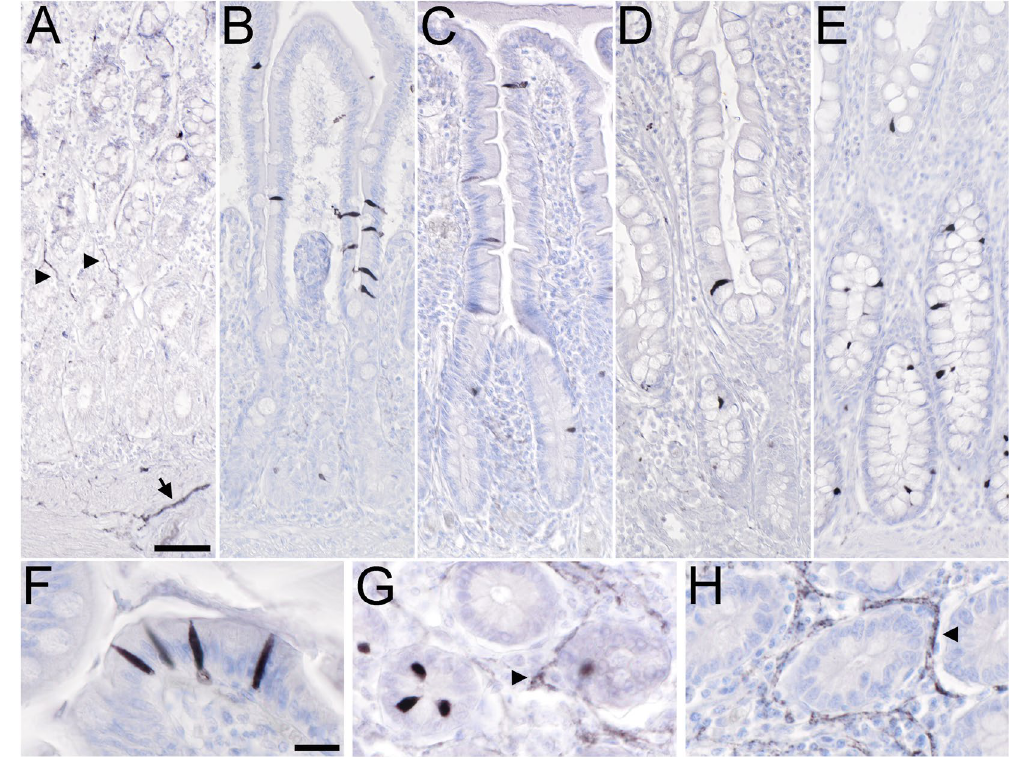
Figure 1. Distribution of non-neuronal ChAT-immunoreactive cells in the human gastro-intestinal tract mucosal epithelia. ( A ) In the stomach, ChAT-immunoreactive (ir) nerve fibers trespass the mucosal glands (arrowheads) and the muscle layers (arrow). Epithelial cell body staining is not detectable. ( B ) In the duodenal mucosa, intra-epithelial cells are ChAT-positive. They locate to both, villi and crypts. ( C ) A similar distribution pattern is found in the jejunum. ( D ) In the ileum, ChAT-ir cells mostly locate to the lower third of the villi and to the crypts, while they are mostly absent from the upper two thirds of the villi. ( E ) In the colon, ChAT-ir cells primarily locate to the lower half of the crypts while they are almost absent from the upper half. ( F ) ChAT-ir cell morphology is similar in all aspects of the intestine. Mainly in villi, they are slim cells with an oval shape, and span the entire epithelium. A protrusion on the apical side extends into the mucosal brush border. ( G + H ) While ChAT immunoreactivity labels intra-epithelial cells and nerve fibers (arrowhead in G ), VAChT-ir is restricted to nerve fiber plexus (arrowhead in H ), shown here for the jejunum. All sections were counter-stained with hemalaun. For ChAT detection, the goat-anti-ChAT antiserum was used. The bar in A equals 50 µ m and applies to ( A–E ). The bar in ( F ) equals 20 µ m and applies to ( F–H